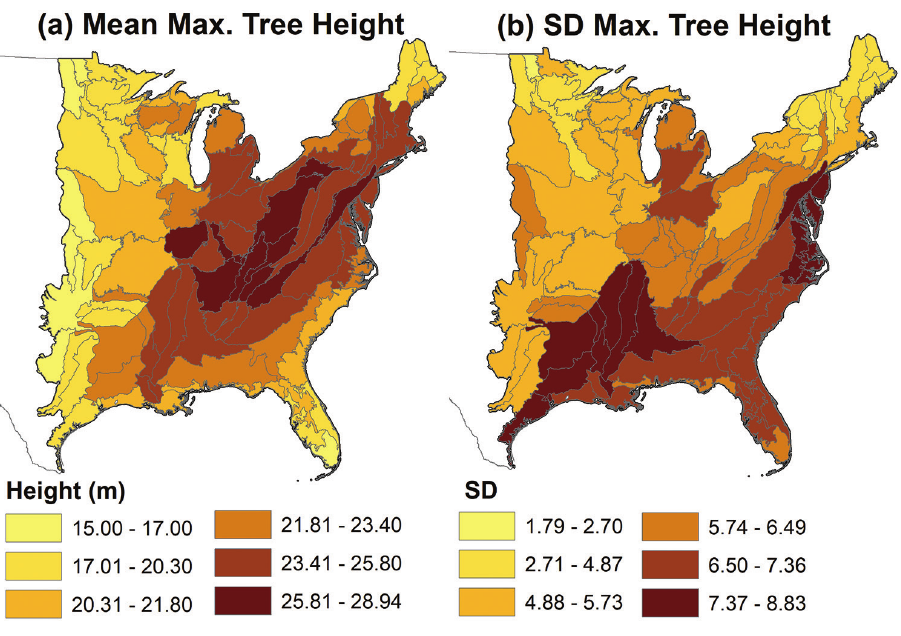
Figure 4. Section level means ( a ) and SD ( b ) for maximum tree height (i.e. an inverse metric of envi- ronmental